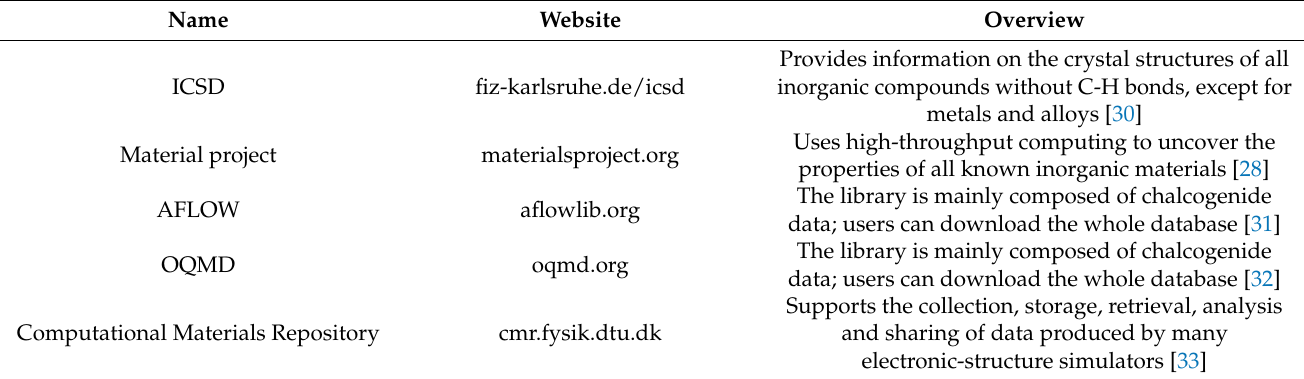
Table 1. Overview of some material